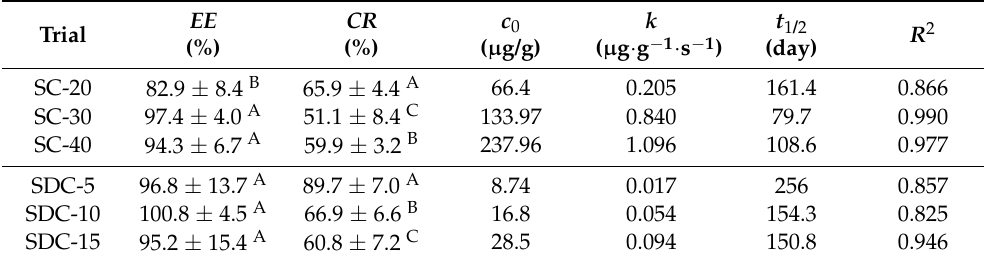
Table 1. Encapsulation efficiency ( EE , %), retention index ( CR , %) after 90 days of powder storage, initial concentration ( c 0 , µ g/g), and regression coefficients ( k , t 1/2 , and R 2 ) of zero-order reaction